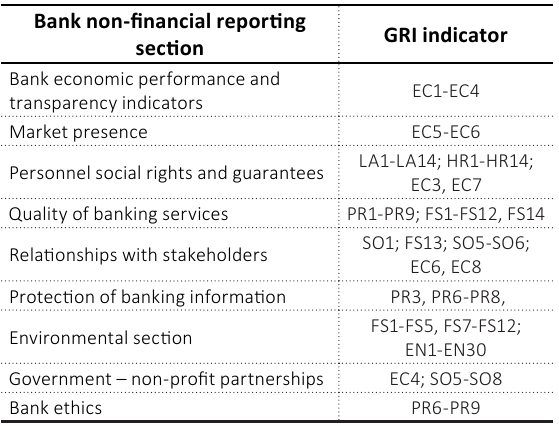
Table 1. The correlation of bank